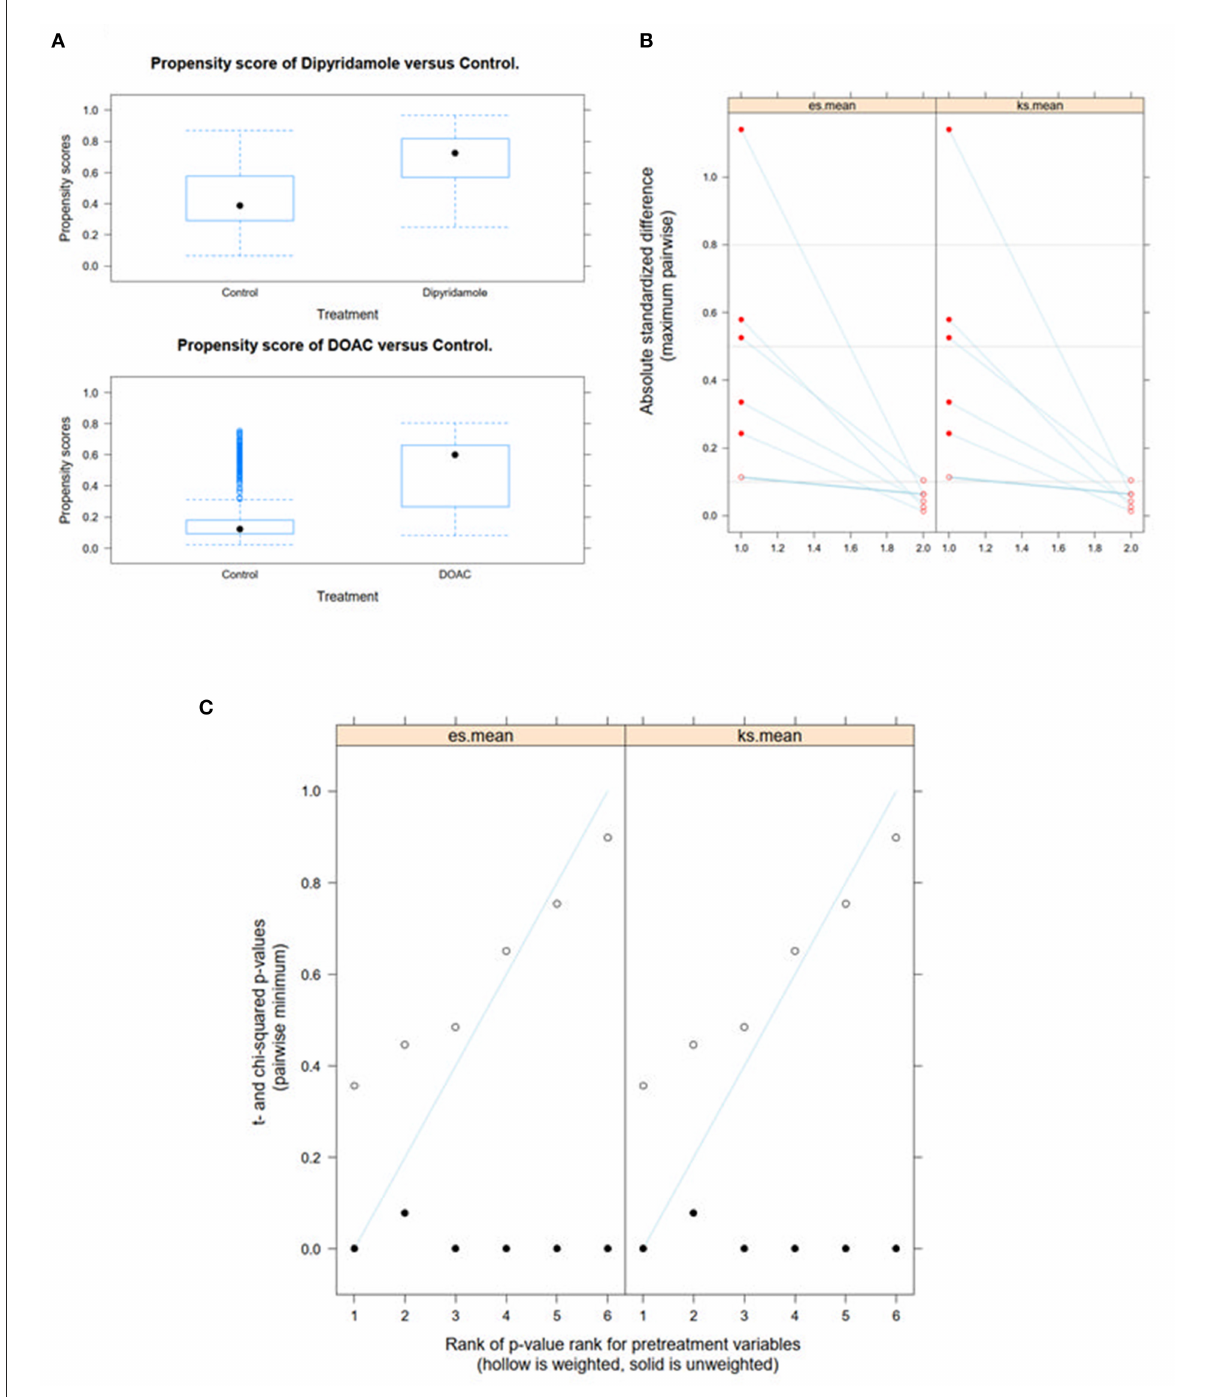
FIGURE6 Propensity score weighting of groups was performed by applying Generalized Boosted Models (GBM) using the Average Treatment Effect on Treated (ATT) estimate. (A) depicts boxplots of the overlap of propensity score distribution between the three groups, (B) the comparison of the absolute standardized mean differences (ASMD) of the selected covariates between the groups before and after weighting and (C) the t -test and χ 2 statistic before and after